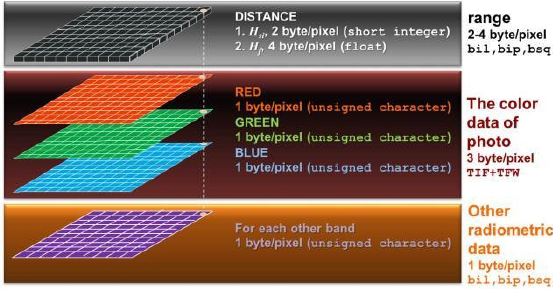
Figure 2. RGB-D structure.